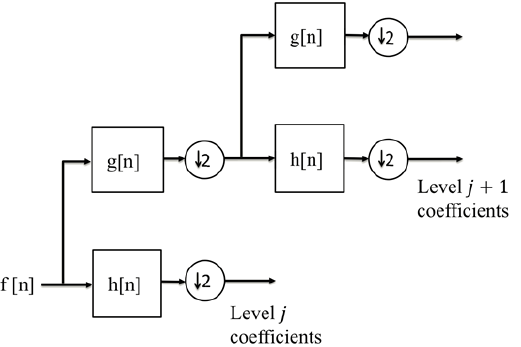
Figure 4. Implementation of level- j and level- ( j + 1 ) MRA filter